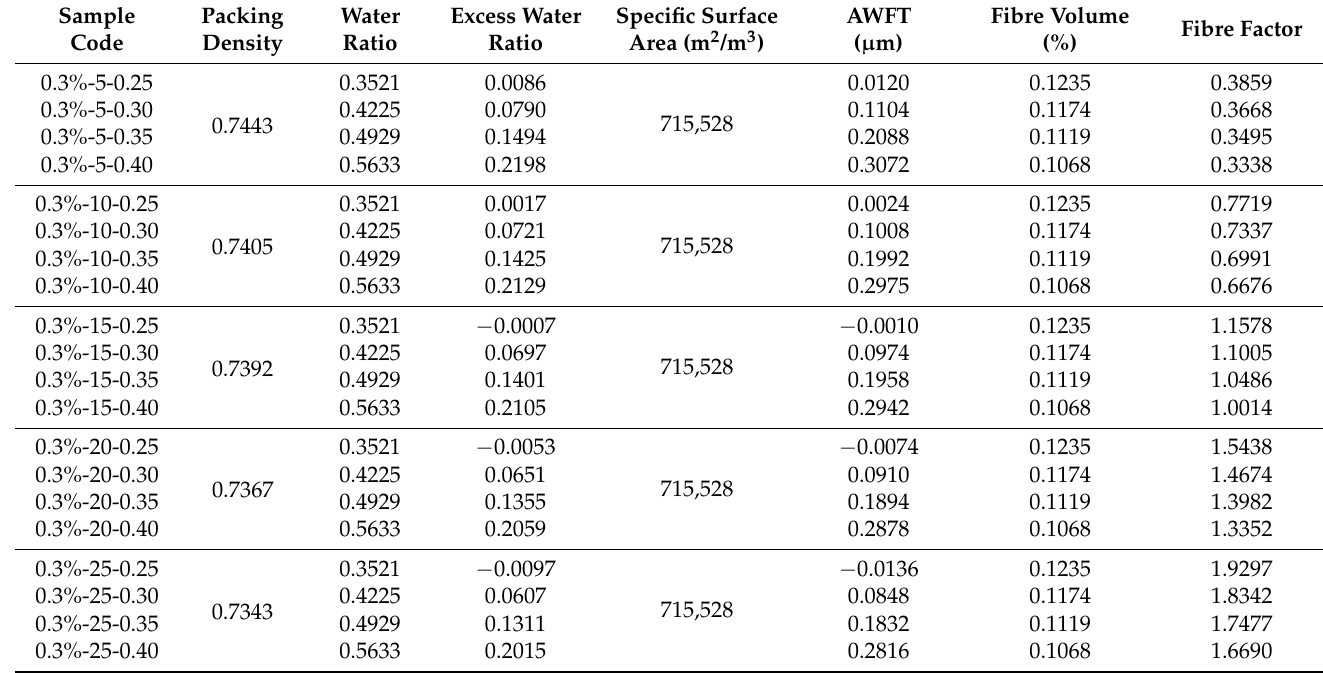
Table 7. Packing density and AWFT with fibre dosage = 0.30% and varying